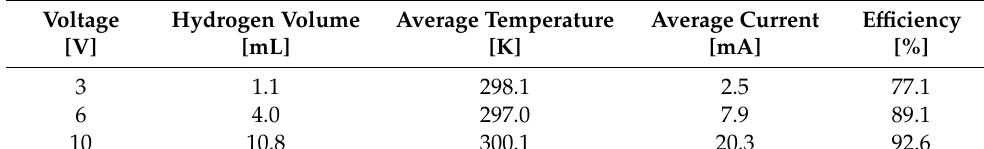
Table 4. Experimental results according to the applied voltage.